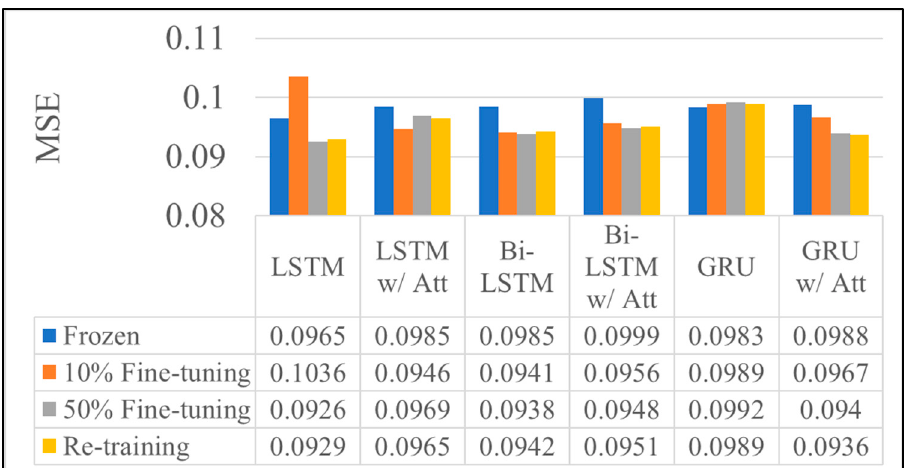
Figure 13. MSE of the target disease course prediction of TL-CDC with attention mechanism under k = 3.